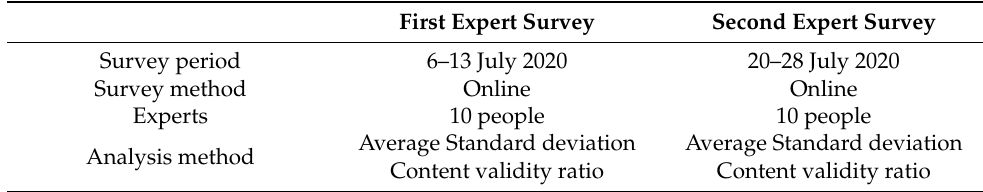
Table 3. Status of first and second expert surveys.